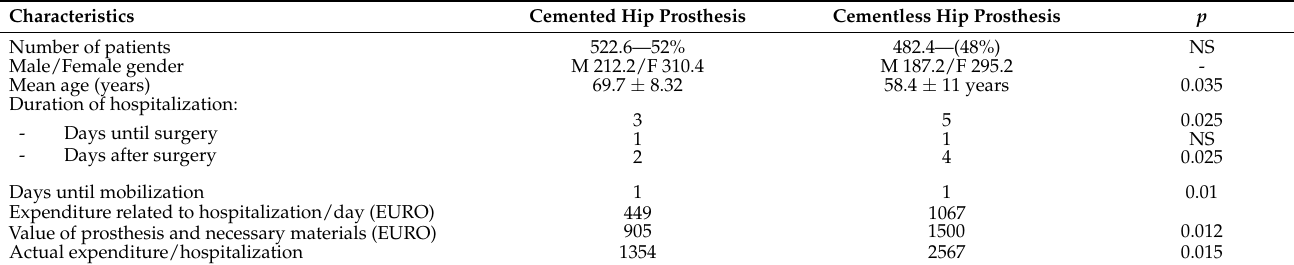
Table 3. Characteristics of patients, duration of hospitalization, and expenditure costs for THA during the COVID-19